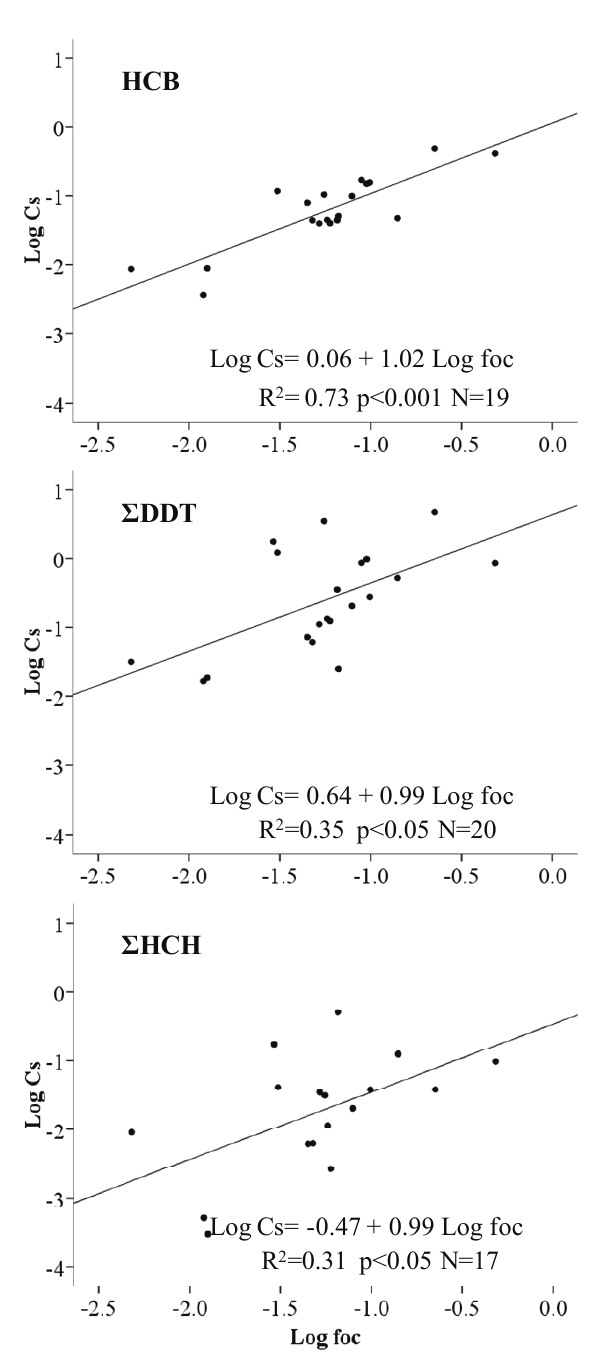
Fig. 2. Concentrations in soil (Log Cs in nggdw − 1 ) versus soil organic carbon (Log f OC )